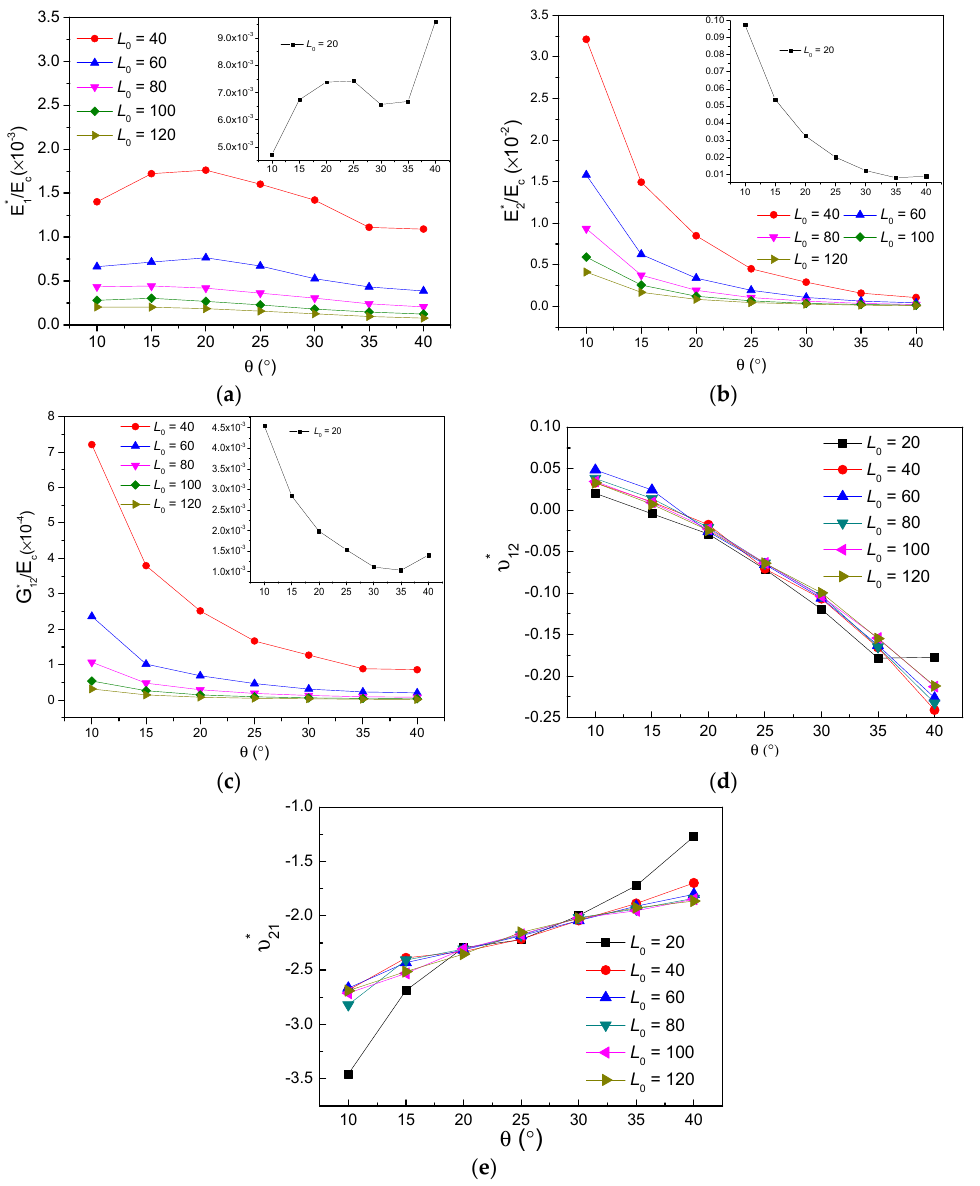
θ on the effective mechanical property for 2 t L and 0 ν ν , ( e ) ν ∗ * * E 12 21 , ( d ) , ( e ) . 12 21